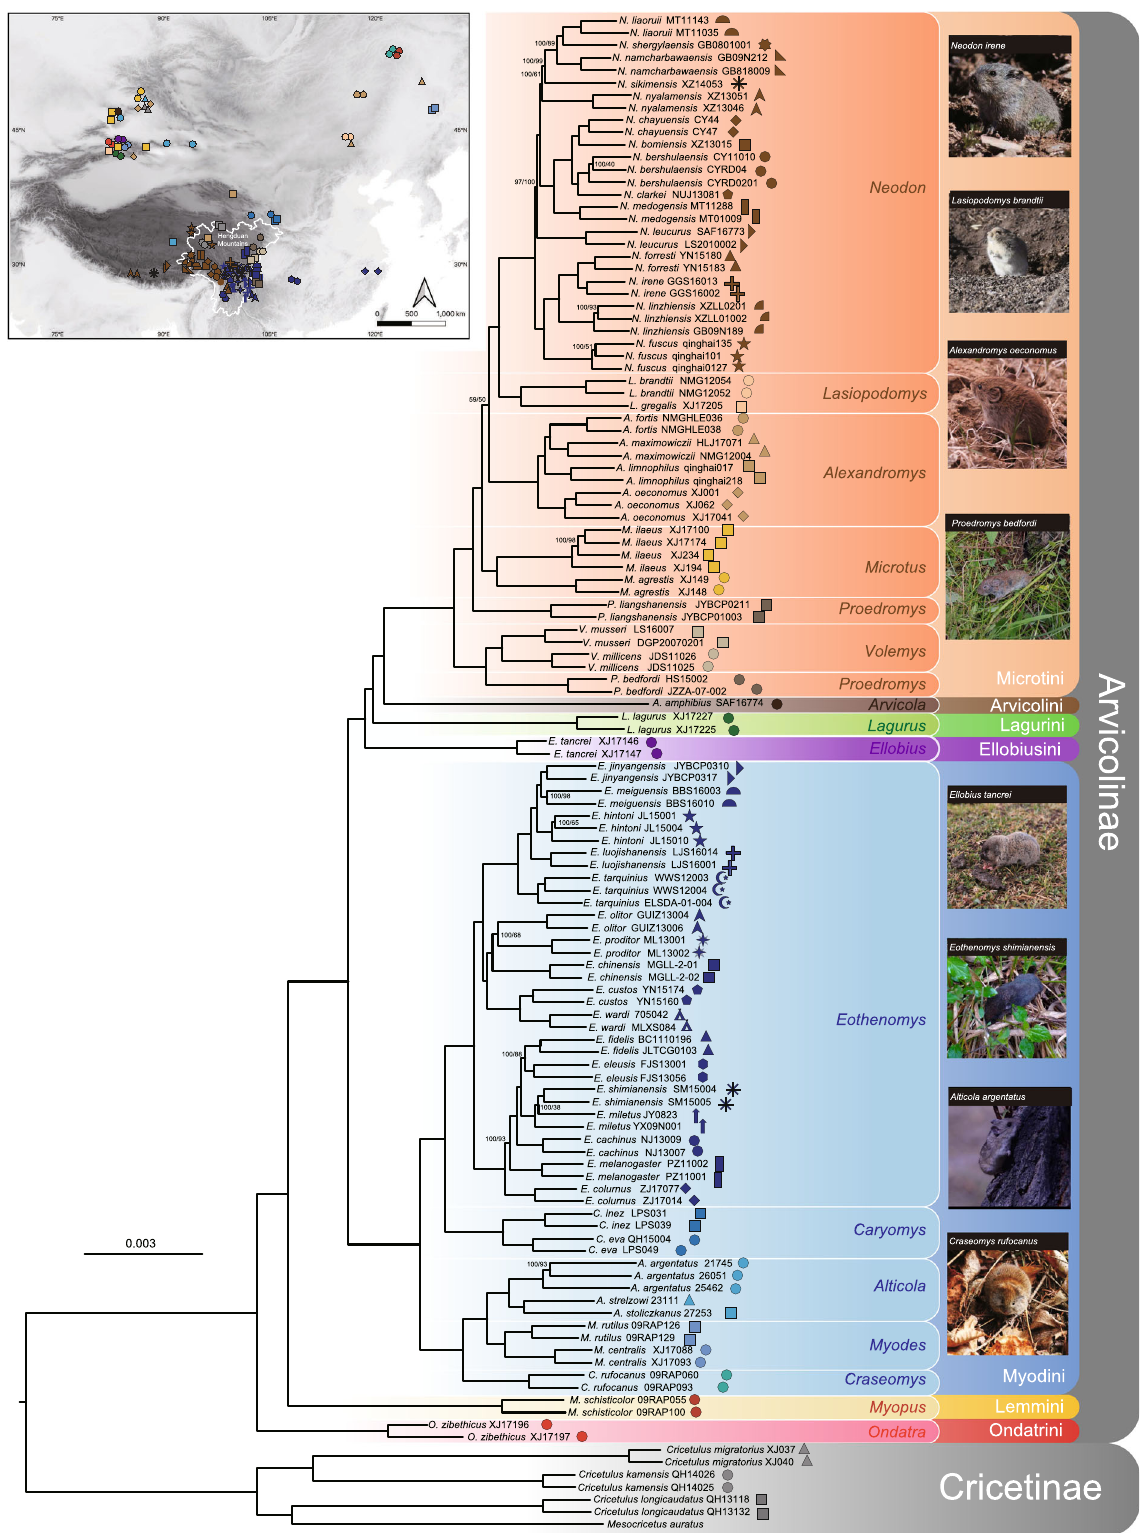
and Craseomys . Their species are widespread across the Northern Hemisphere. Another lineage included Caryomys and Eothe- nomys . Caryomys is mainly distributed in the monsoon areas of Eastern Asia, and Eothenomys is mainly distributed in the HDM region. Tribe Microtini contained three HDM genera, Volemys ,